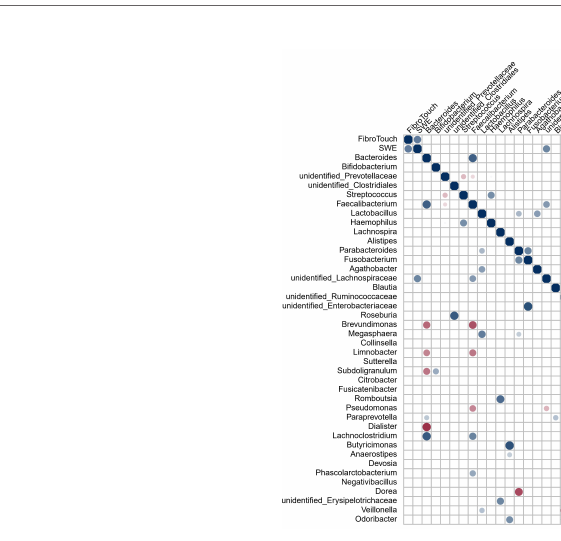
FIGURE 6 | Spearman correlation for variables during fi brosis disease (induced by non-parasitic factors, hepatitis B virus) in humans (n = 12) was shown. Information of participants of study on liver fi brosis induced by non-parasitic factors wes shown in Table S1 . The methods of FibroTouch and SWE were clinical evaluation strategies in humans. The circle size indicates the magnitude of the correlation. The circle in color indicates P < 0.05, P < 0.01 or P <